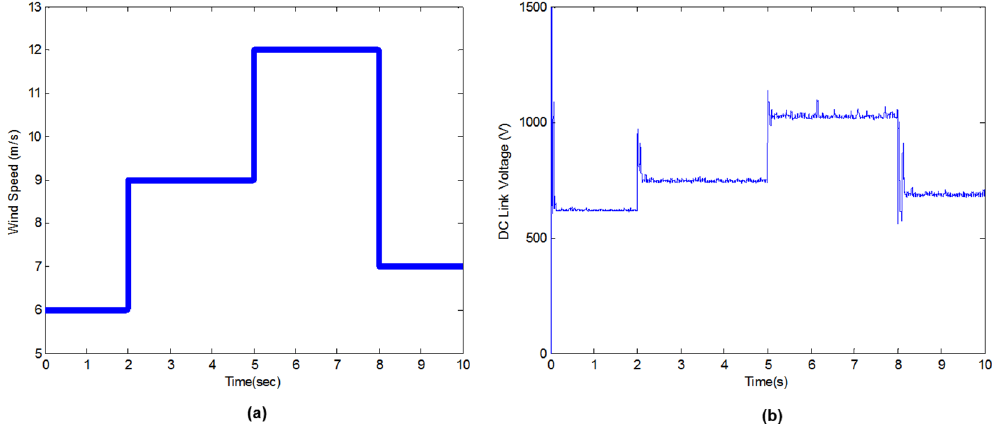
Figure 9. ( a ) Wind speed profile; ( b ) Adjusted DC link